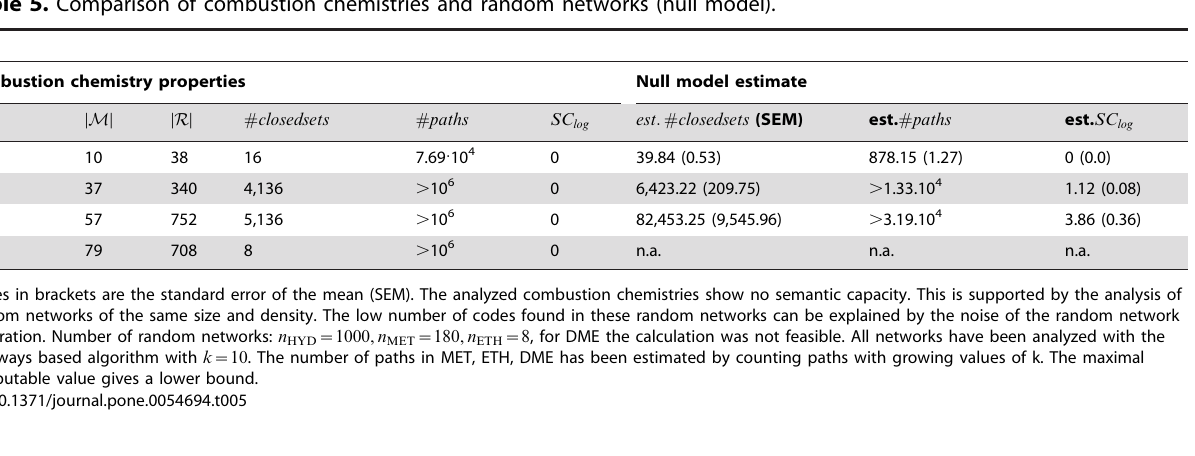
Table 5. Comparison of combustion chemistries and random networks (null model).